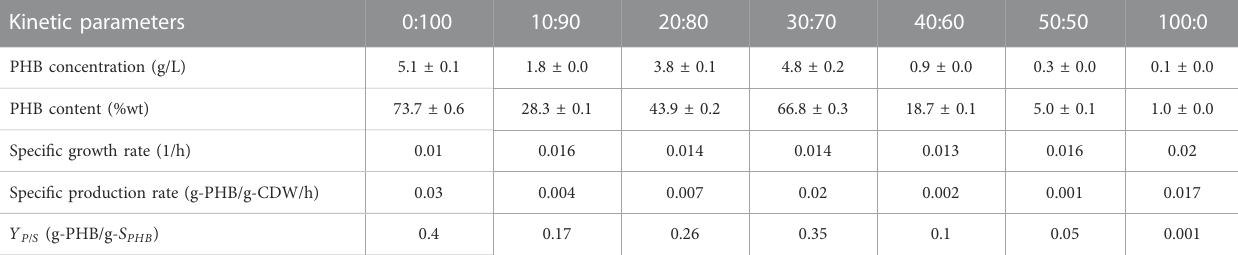
TABLE 4 Kinetics of cell growth, sugar consumption and PHB productionby Cupriavidus necator strain A-04 using hydrolysate mixed with mineral salts medium 0: 100, 10:90, 20:80, 30:70, 40:60, 50:50 and 100:0 (v/v) where C/N ratio was set at 200 in all experiments. Kinetic